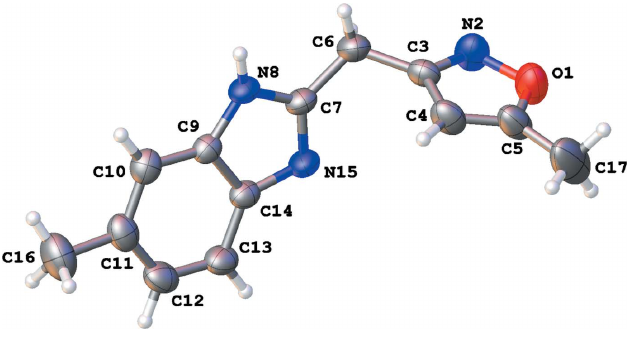
Figure 1 Molecular structure of the title molecule with the atom labeling scheme and 50% probability